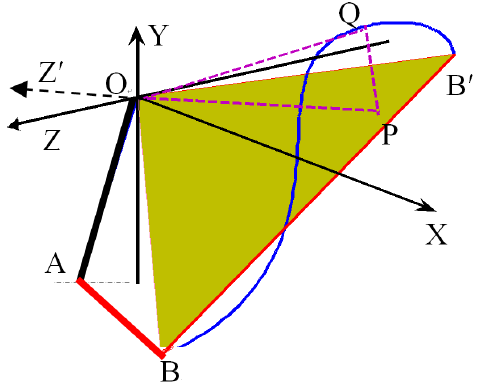
Figure 9. Simplified sketch of exoskeleton manipulator coordinate system.